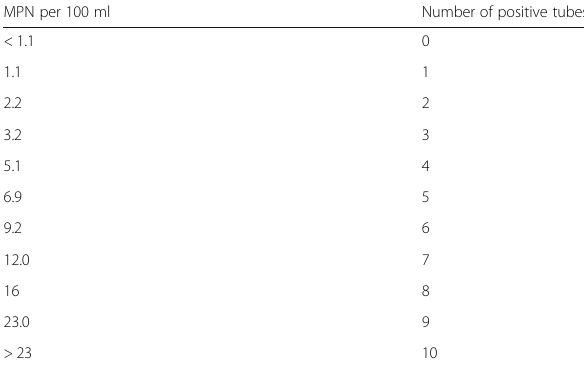
Table 3 Groundwater data compared with the maximum permissible concentration for drinking water according to the (WHO Guidelines 2004) and Egyptian limits (Egyptian Higher